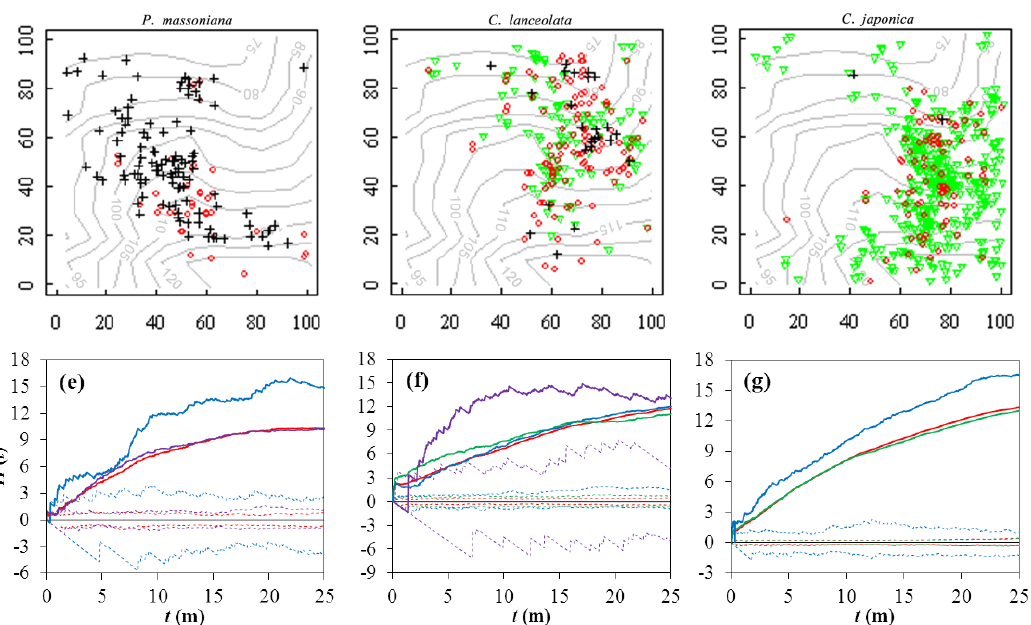
Figure 3. Visual distribution maps and spatial patterns of all species and the six dominant species for all stems as well as stems at different vertical layers in the subtropical broadleaved evergreen forest plot on Dashanchong Forest Farm, China. The green triangle, red circle and black cross denote understory, middle-story, and overstory woody species, respectively. The solid lines denote Ĥ ( t ) values and dashed lines are the upper and lower limits of the 95% confidence envelope of Ĥ ( t ) generated by 999 computations of Monte Carlo (where t is distance). ( a ) all common species of the community; ( b ) L. glaber ; ( c ) C. glauca ; ( d ) C. axillaris ; ( d ) P. massoniana ; ( e ) C. laceolata ; and ( f ) C.